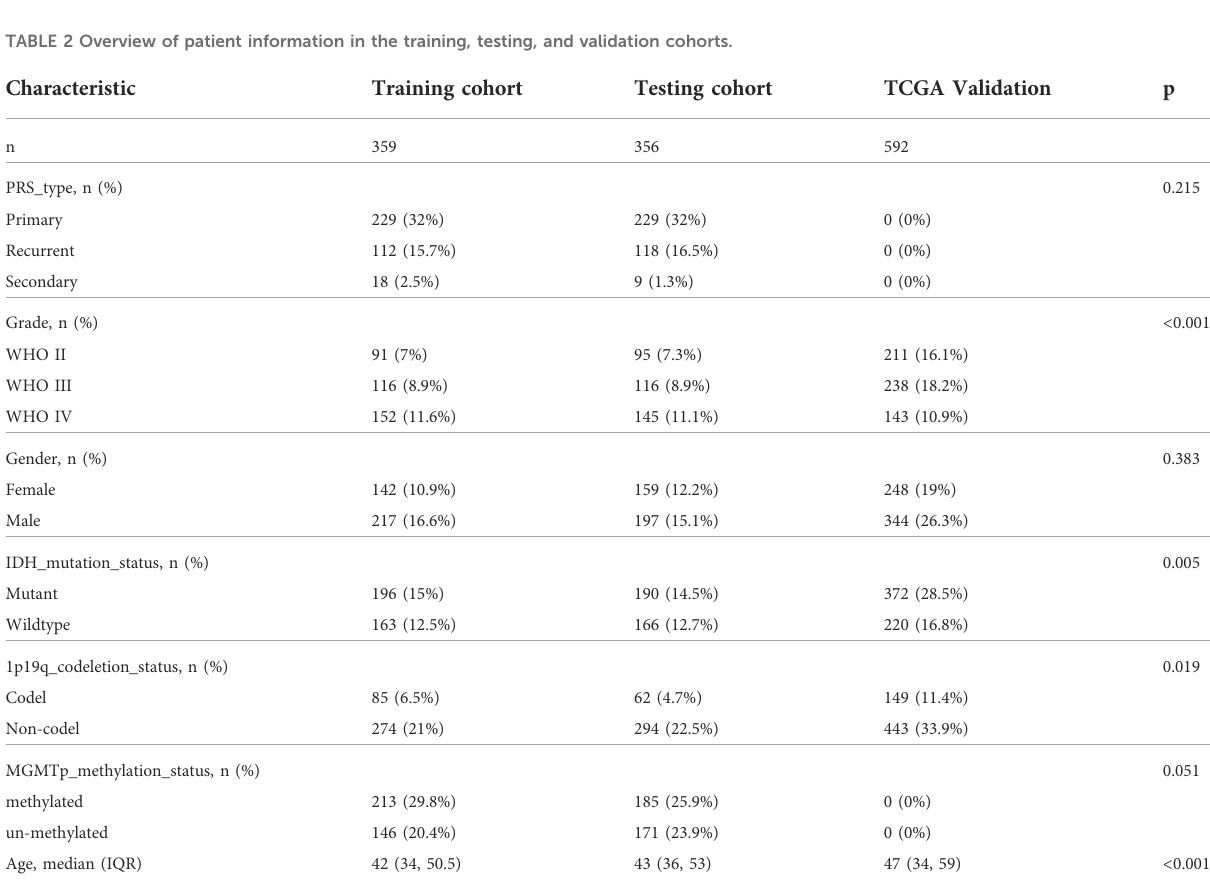
TABLE 2 Overview of patient information in the training, testing, and validation